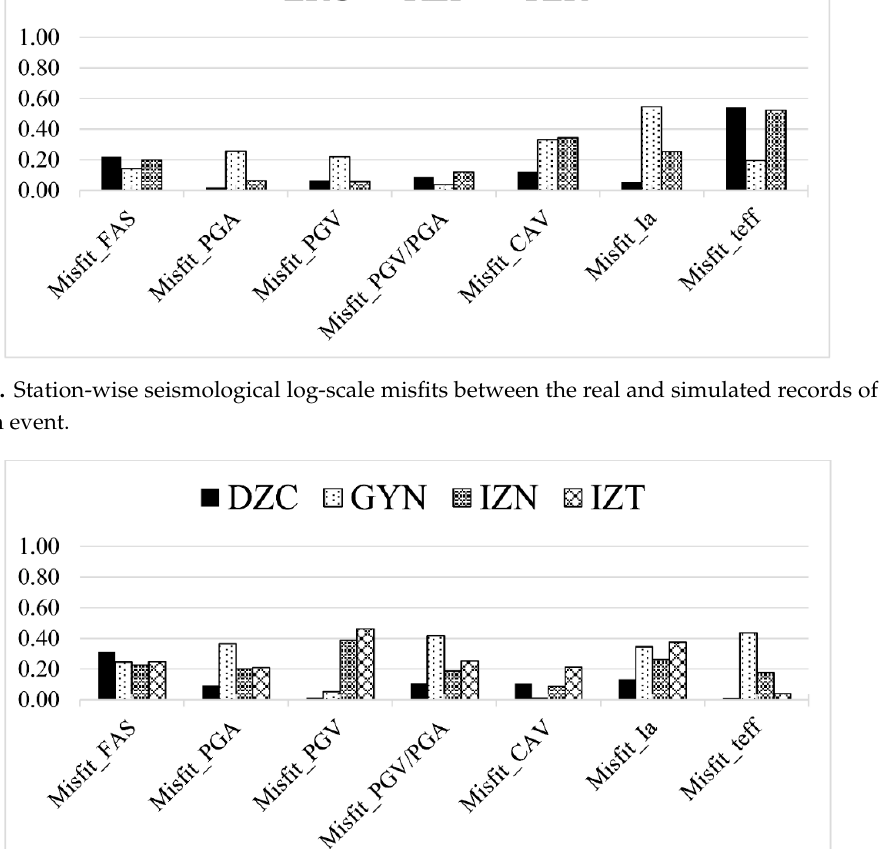
Figure 5. Station-wise seismological log-scale misfits between the real and simulated records of the Duzce event.